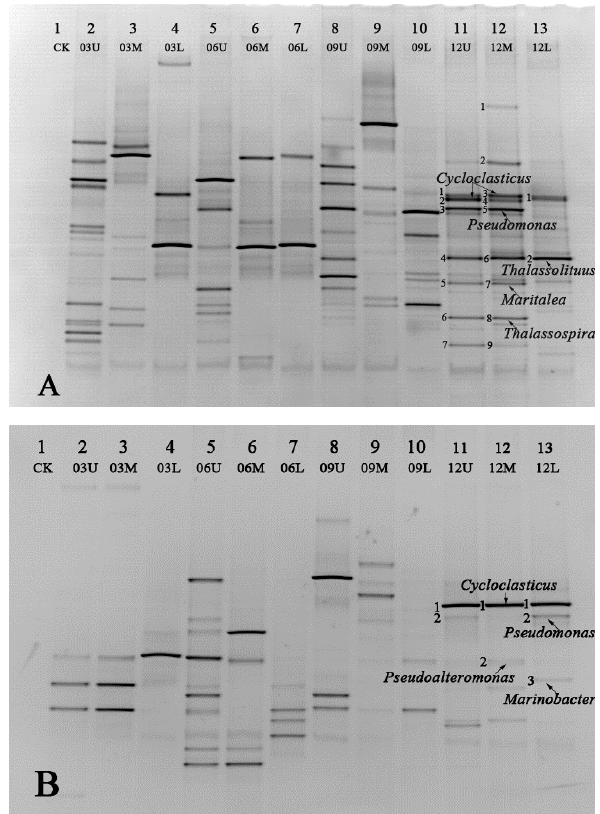
Figure 6. PCR-DGGE profiles of PAH-degrading consortia that were enriched at low temperatures. Lane CK, negative control; (a) consortia enriched at 4 ◦ C; and (b) consortia enriched at 15 ◦